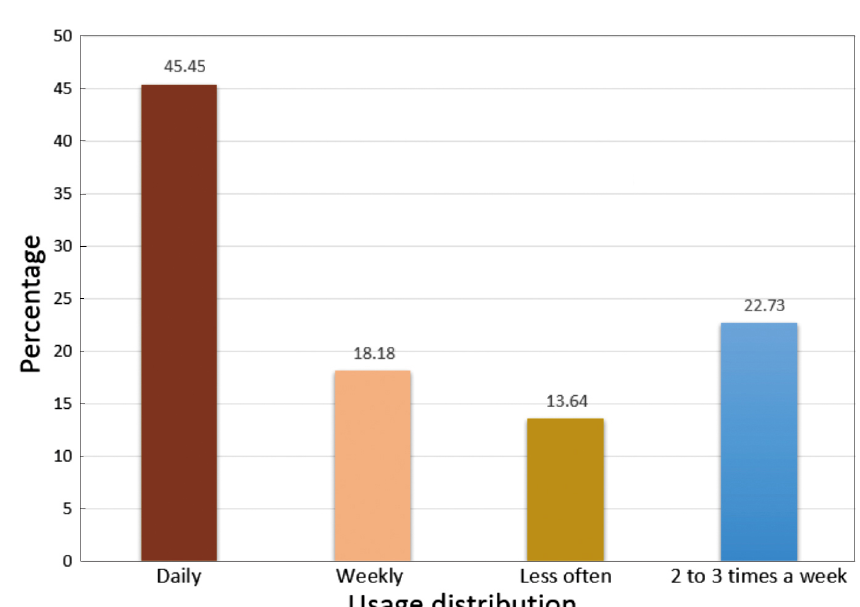
Fig. 4 Social media profile usage distribution of survey